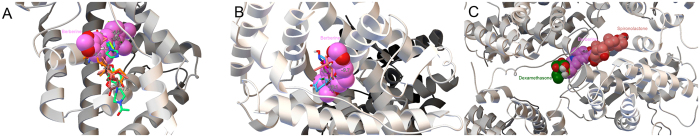
Drugs dock in the same site in targets.(A) Docking site between AR and drugs. (B) Docking site between PGR and drugs. (C) Docking site between NR3C1 and drugs.